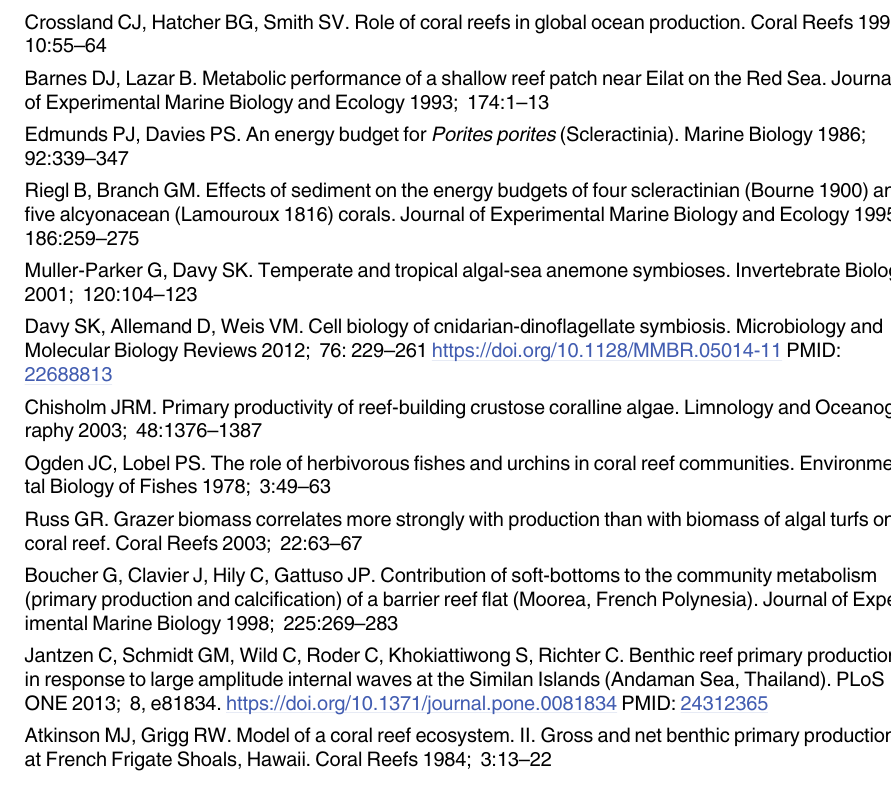
S2 Table. Mat lab file containing all the normalized diel PAR curves used for modeling. The variable "Normalized_PAR" contains 928 diel curves of normalized PAR. Each column is a single diel curve. These curves represent the range from cloudy days with short photoperiod to sunny days with long photoperiod. These values can be scaled by E cific instantaneous P-E curve, as given in S1 Table. The variable "Time_of_Day" is a single col- umn vector with time of day from midnight to midnight in decimal days, at one-minute intervals. The file was written using Matlab version